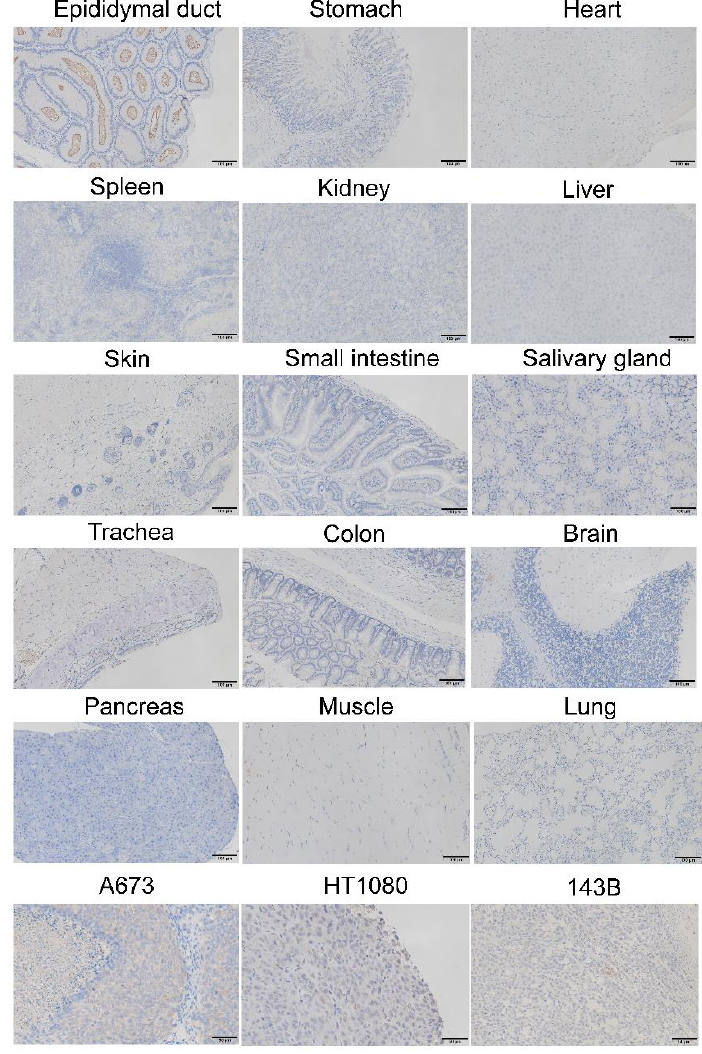
Figure 8. GPR64 expression in tumors and normal organs resected from IgG1 isotype control antibody-injected mice. Tumor (A673, HT1080, 143B): original magnification, ×400. Normal organs: original magnification, ×200.